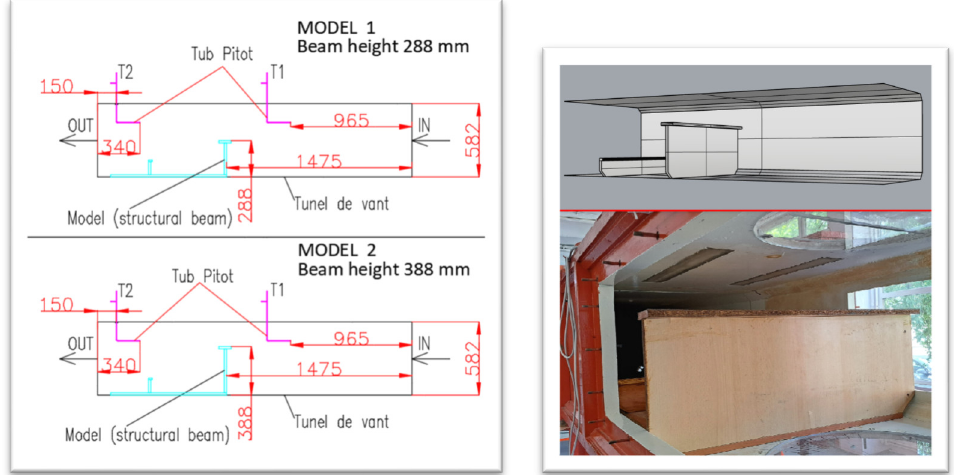
Figure 5. Sketch for measuring points of the experimental model (Model 1 with a beam height of 288 mm and Model 2 with a beam height of 388 mm).